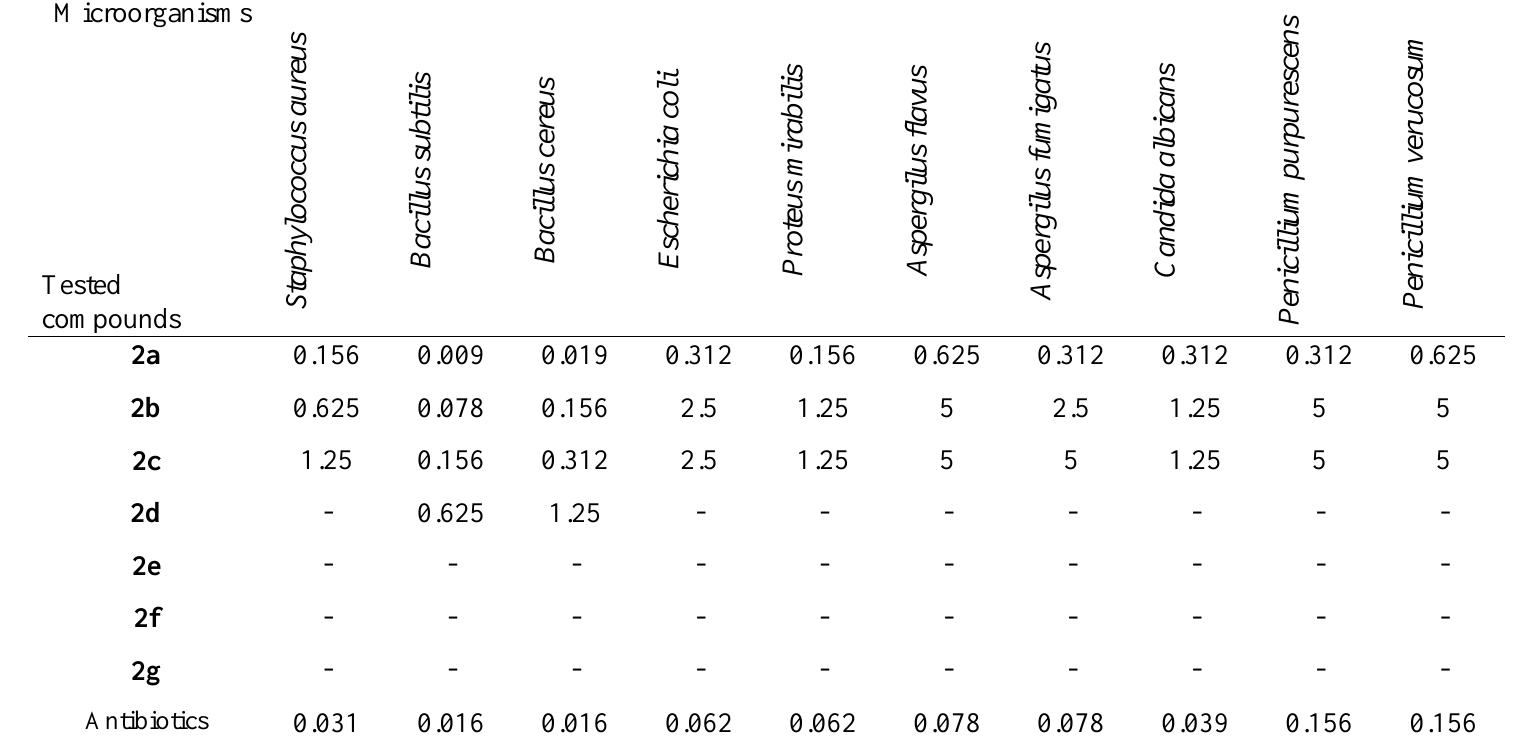
Table 1. Minimum inhibitory concentration (MIC) of tested compounds